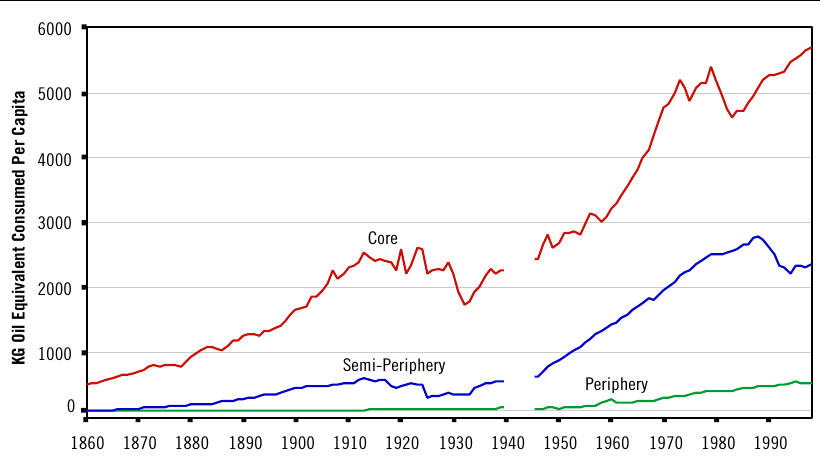
Figure 1 – Commercial Energy Production and Consumption, 1860–1998 Figure 2 – Per Capita Commercial Energy Consumption, 1860–1998